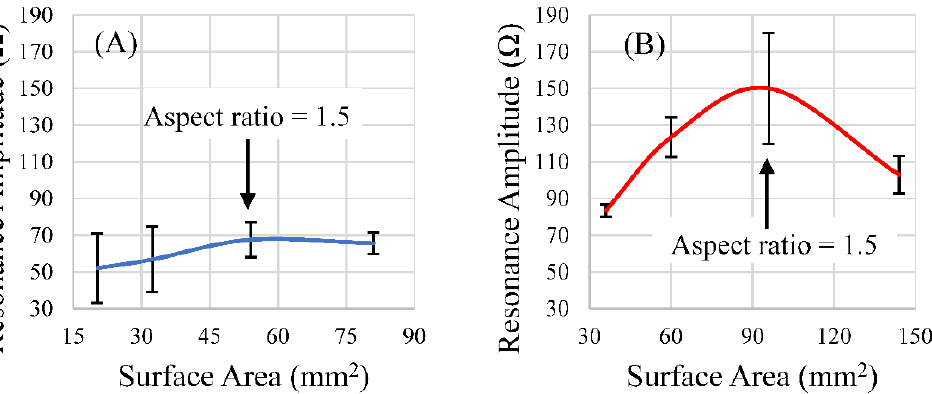
Figure 11. The responses of rectangular sensors fabricated at lengths 9 mm ( A ) and 12.7 mm ( B ) with varying widths were plotted against the surface area of those sensors. ( n = 4; error = ± standard deviation).